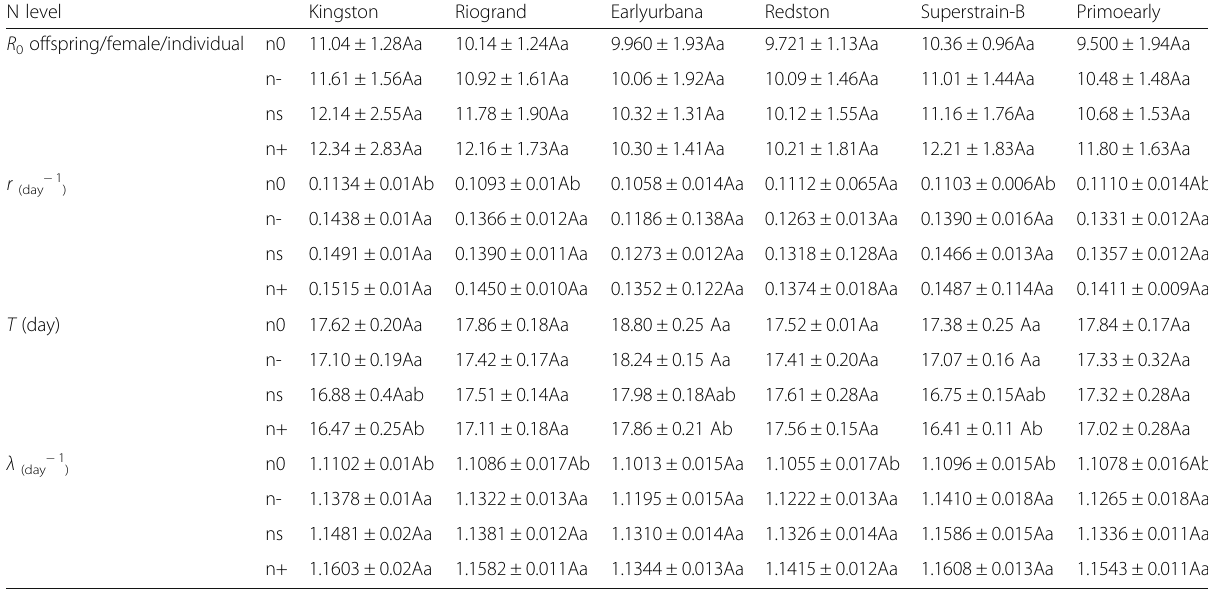
Table 4 Age-stage, two-sex life table parameters of H. hebetor on H. armigera reared on six tomato cultivars with four nitrogen